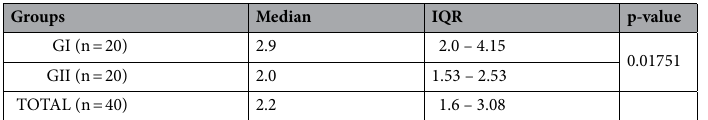
Table 2. Values of medians and interquartile range (IQR—first and third quartiles) of the oral hygiene index in relation to groups I and II and the total number of children and young people. GI group with gastrostomy, GII Group without gastrostomy.